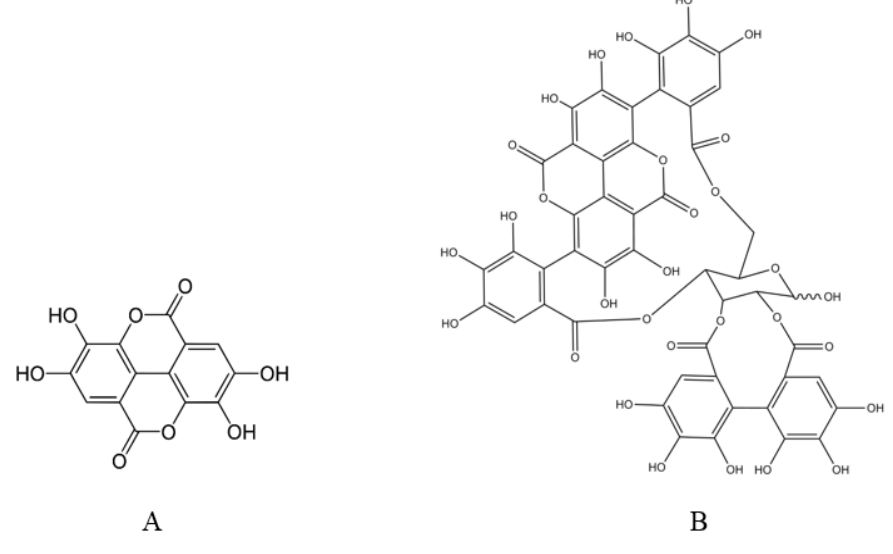
Figure 1. Chemical structure of Ellagic acid ( A ) and Punicalagin ( B ). Due to this variability, many studies have used purified compounds, rather than polyphenol-rich pomegranate